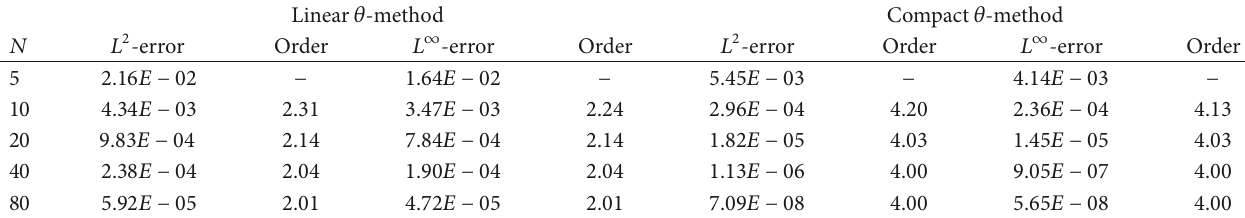
Table 4: Errors and convergence orders when 𝜃 = 1 , 𝑇 = 2 , and 𝜏 = 0.5. Linear 𝜃